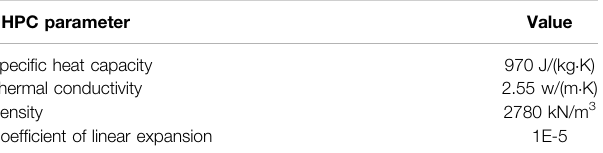
TABLE 1 | Thermal parameters of UHPC materials.